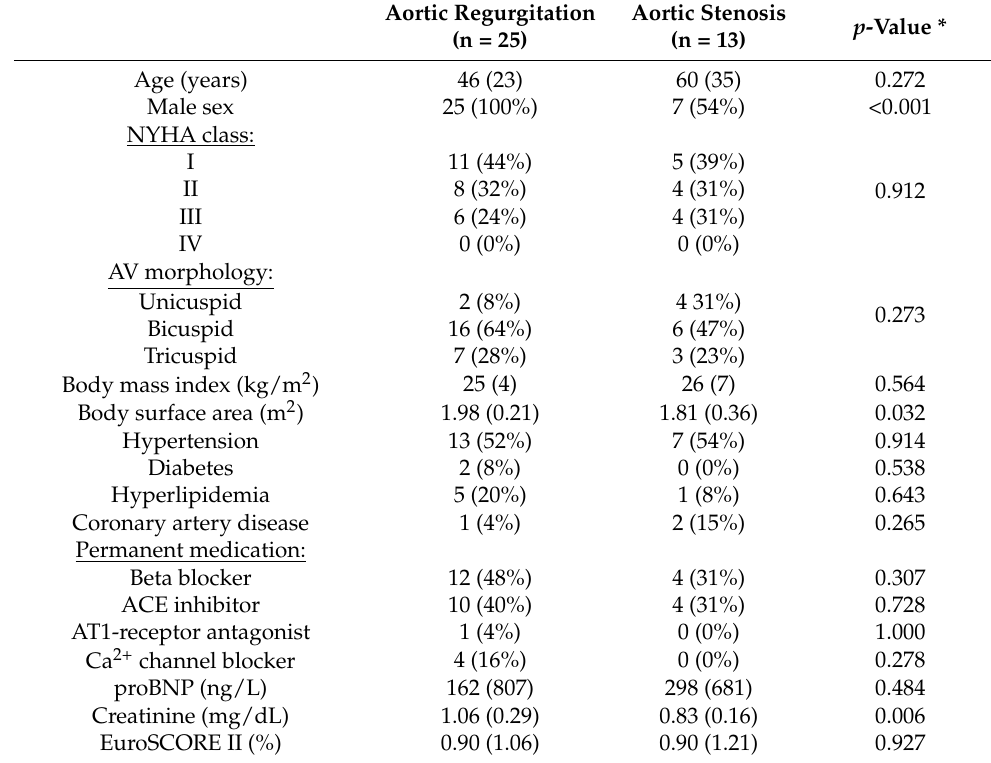
Table 1. Preoperative patient